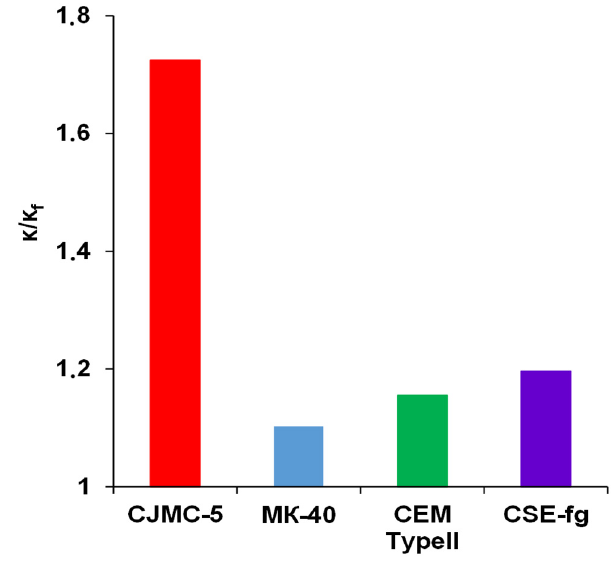
Figure 5. Ratios of the specific electrical conductivities of pristine membranes and membranes soaked in cranberry juice for 168 h.